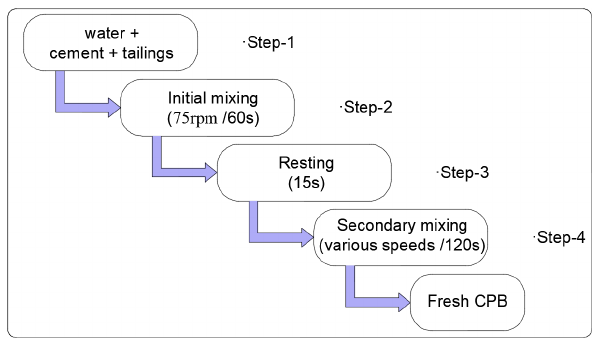
Figure 2: High-shearing-type mixer.